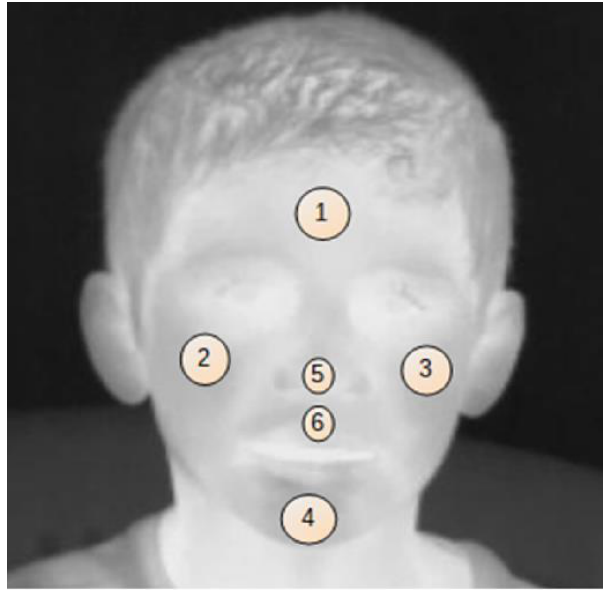
Figure 7. Areas of interest.